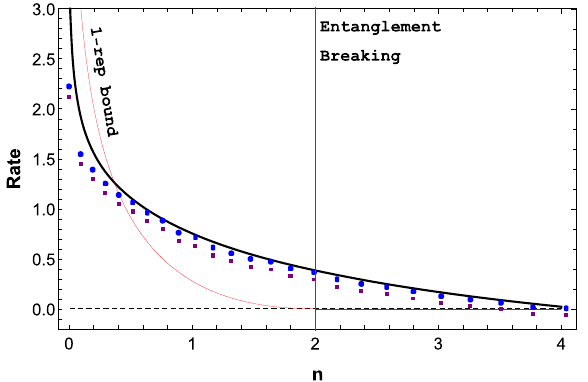
blue circles refer to ideal reconciliation and purple squares to achievable reconcilation ef fi ciency ( ≃ 0.97). Error bars on the x -axis (associated with the correlated side-channel